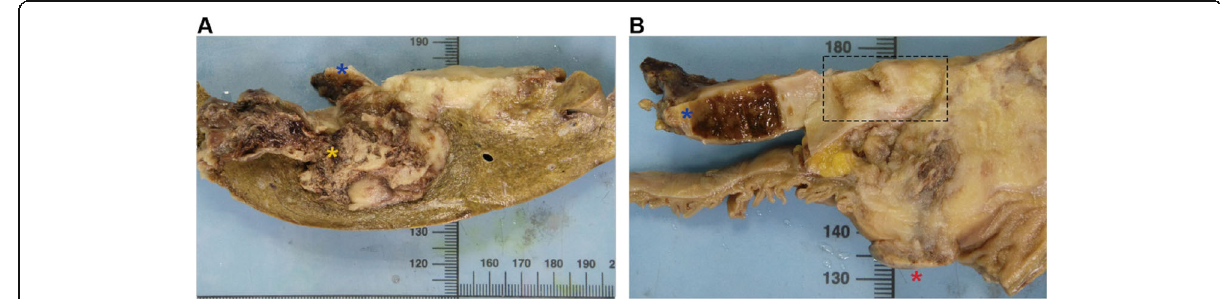
Fig. 2 Gross appearance of the mass in the cut surface of the resected specimen. a The cut surface shows the mass perforating the gallbladder wall, with invasion into the liver parenchyma. b The cut surface shows invasion of the mass into the duodenal wall and protrusion into the duodenal lumen. The foci of the mass in the neck of the gallbladder (black dotted box) has a papillary appearance. The blue asterisk represents the non-tumor fundus of the gallbladder. The yellow asterisk represents the liver parenchyma infiltrated by the tumor. The red asterisk represents the tumor protruding into the duodenal lumen. The black dotted box highlights the focal papillary